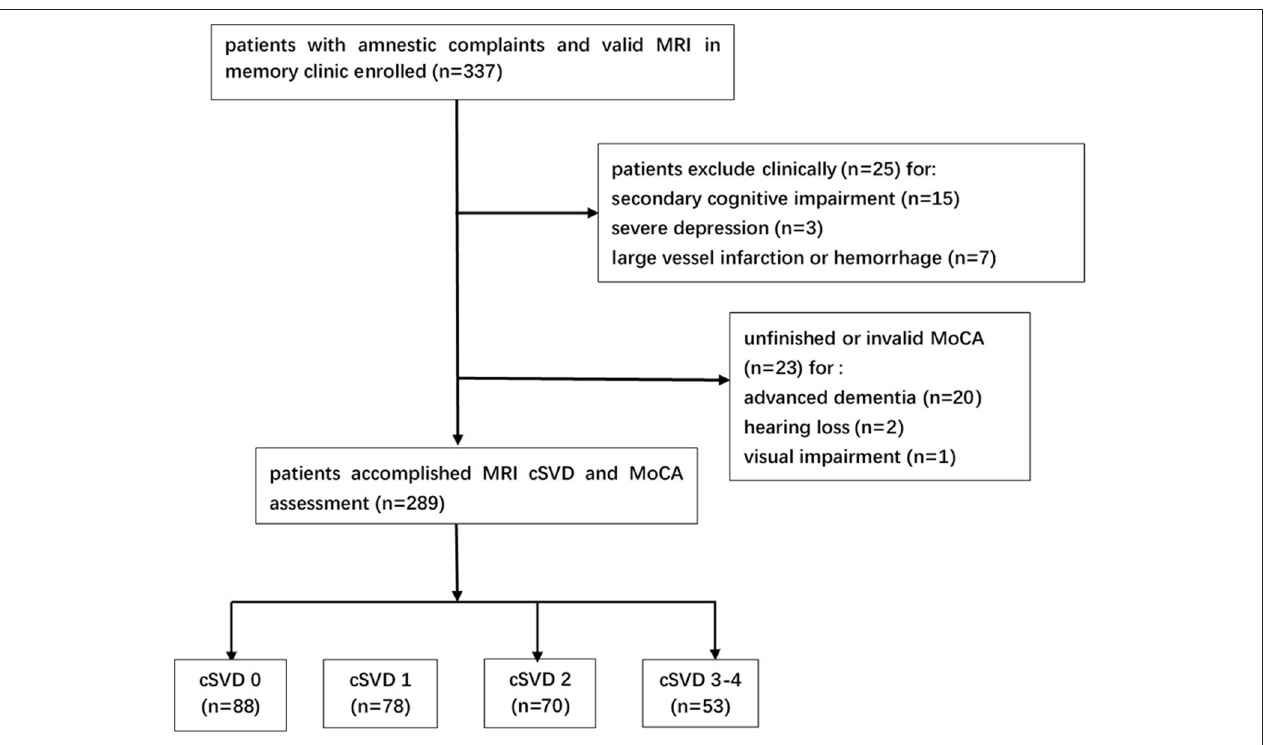
FIGURE 1 | Study flowchart. MRI, magnetic resonance imaging; cSVD, cerebral small vessel disease; MoCA, Montreal Cognitive